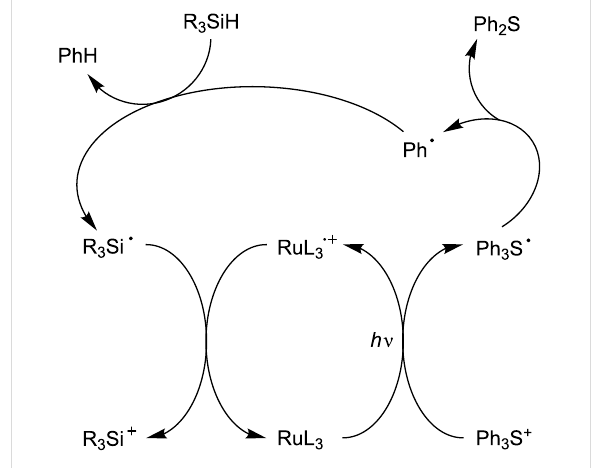
Scheme 7: Reaction mechanisms for the Ru(ligand) 32+ /Ph 3 S + /R 3 SiH